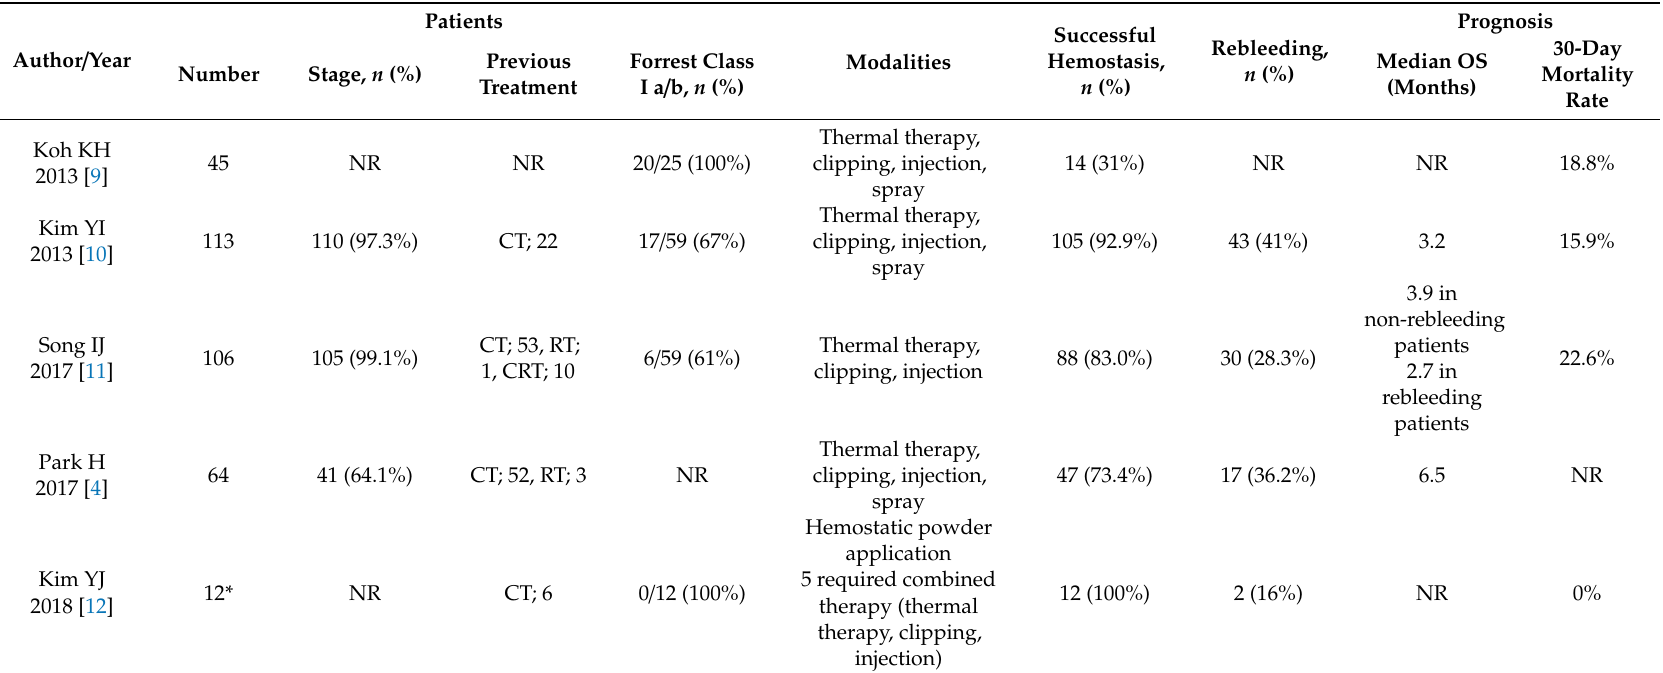
Table 1. Characteristics and results of endoscopic therapy for bleeding from gastric